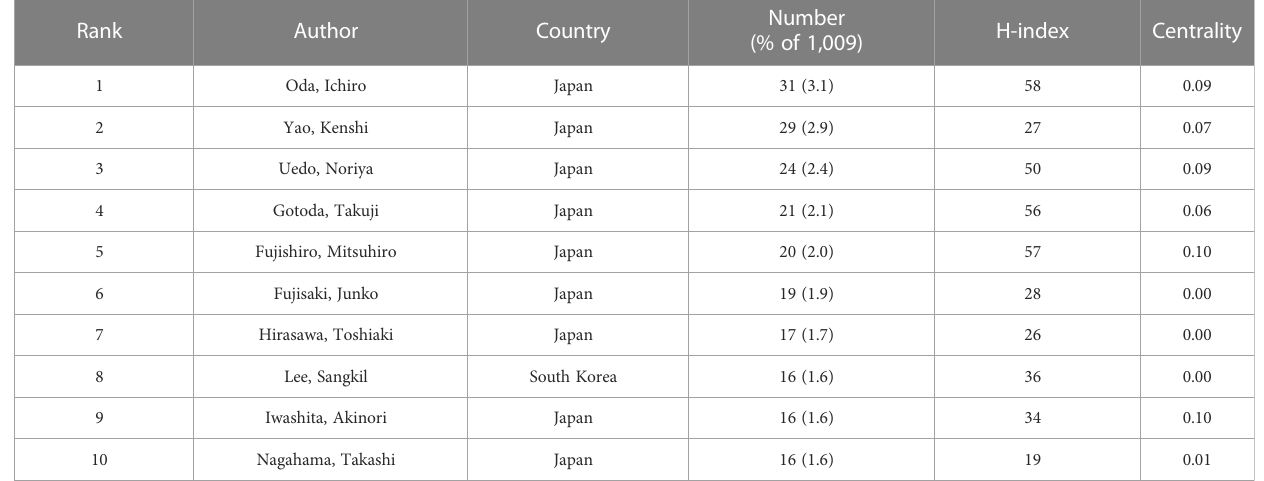
TABLE 4 Top 10 authors involved in endoscope on